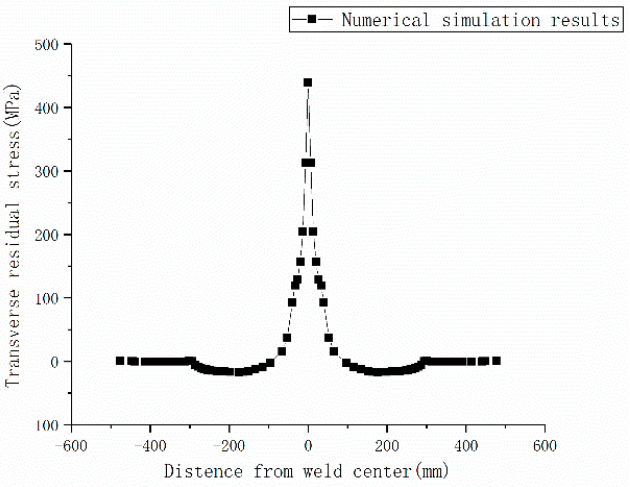
Figure 21. Transverse residual stress along the vertical weld path on the inner surface of the spherical pressure hull.